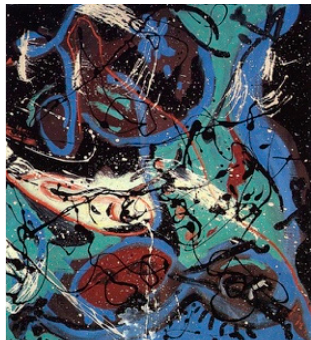
Figure 16. Jackson Pollock, Composition with Pouring II , 1943, oil and enamel paint on canvas, 25 × 22 1/8 in. (63.9 × 56.3 cm). Hirshhorn Museum and Sculpture Garden, Smithsonian Institution, Washington, D.C. Gift of Joseph H. Hirshhorn, 1966. © 2022 The Pollock-Krasner Foundation/Artists Rights Society (ARS), New York.